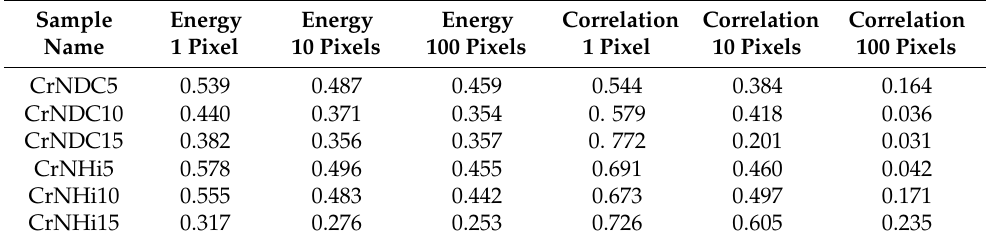
Table 7. Energy feature of the AFM topography GLCM matrix for different pixel distances.